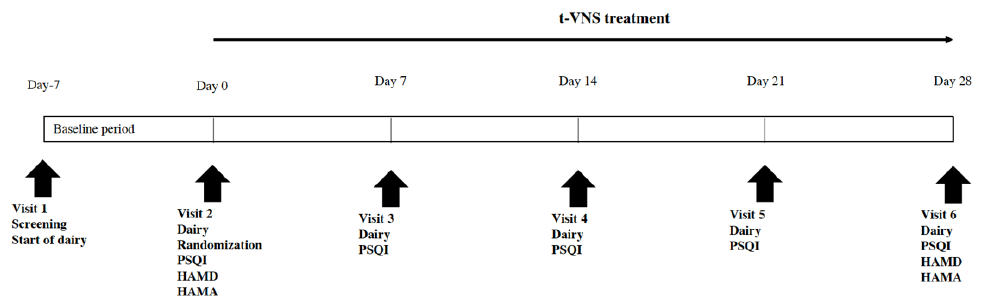
Figure 1. The timeline diagram of the study process, which demonstrates the whole process of study including the follow-up.